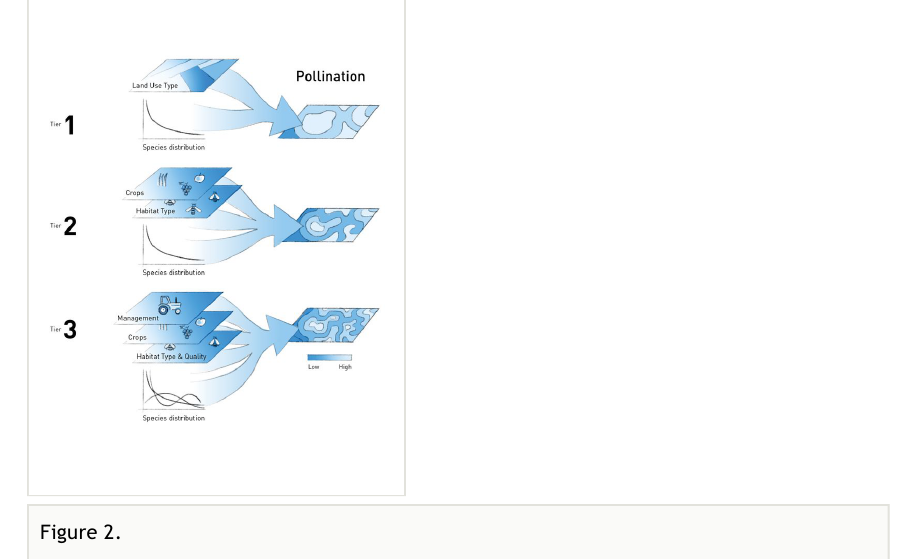
Estimating the pollination service at three di ff erent tier